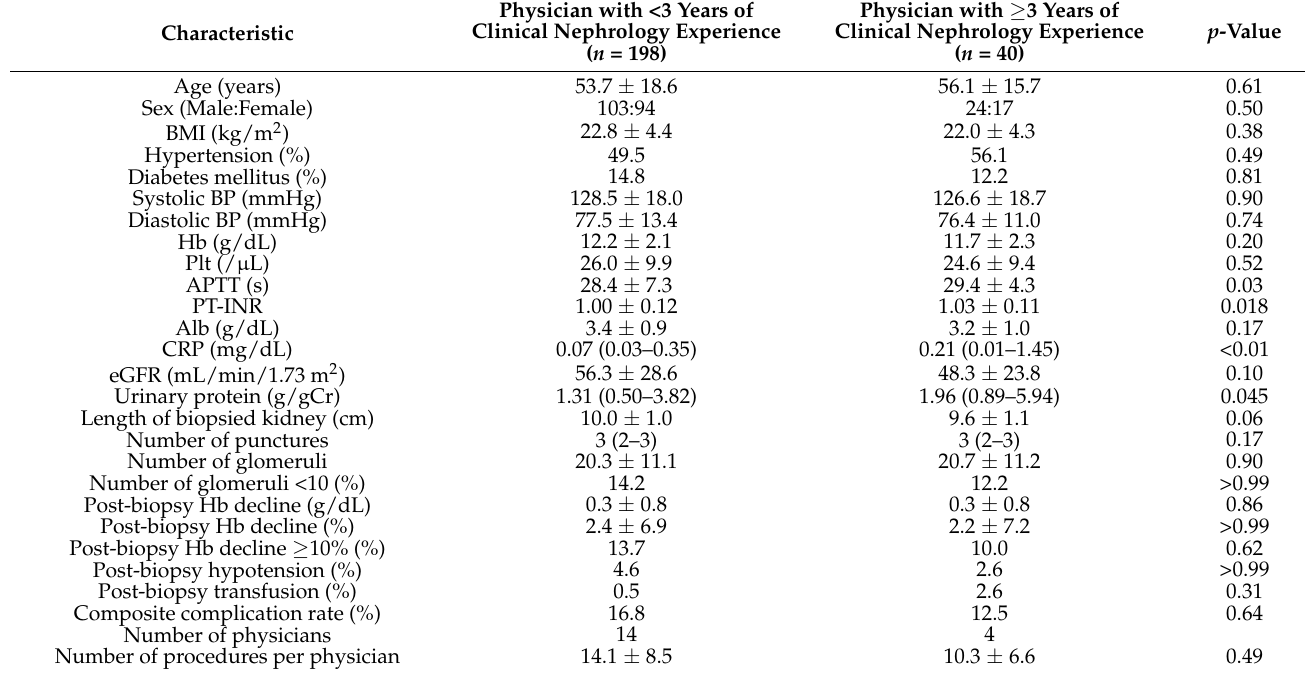
Table 2. Comparison of renal biopsies performed by physicians with <3 years and ≥ 3 years of clinical nephrology